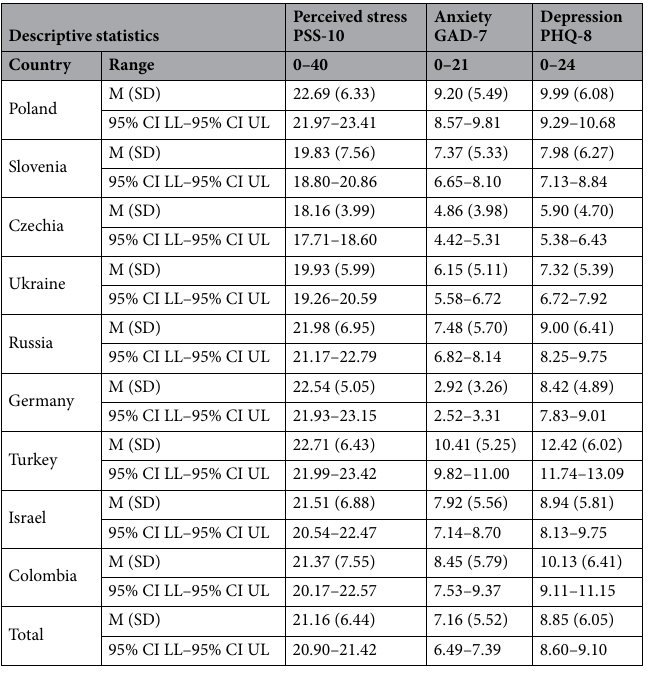
Table 2. Descriptive statistics of perceived stress (PSS-10), anxiety (GAD-7), and depression (PHQ-8) in nine countries (N = 2349). M: mean; SD: standard deviation; CI: confidence interval, LL: lower limit of the confidence interval, UL: upper limit of the confidence interval.